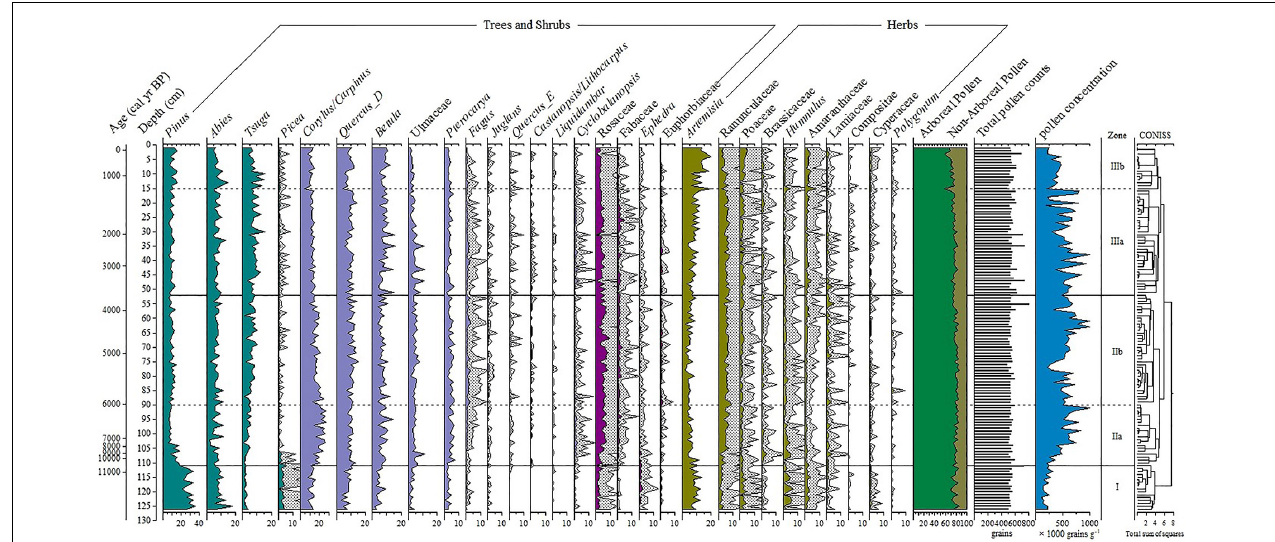
FIGURE 3 | Pollen percentage diagram for core DYH16A from Daye Lake. Only the major taxa are shown (average > 1% and present within at least 70% of the total number of samples). The abundance of arboreal and non-arboreal pollen, the pollen concentration of terrestrial taxa, and the CONISS cluster analysis results are also shown. The dotted shading represents an exaggeration of the scale ( × 5). Quercus _D: Quercus _deciduous; Quercus _E: Quercus